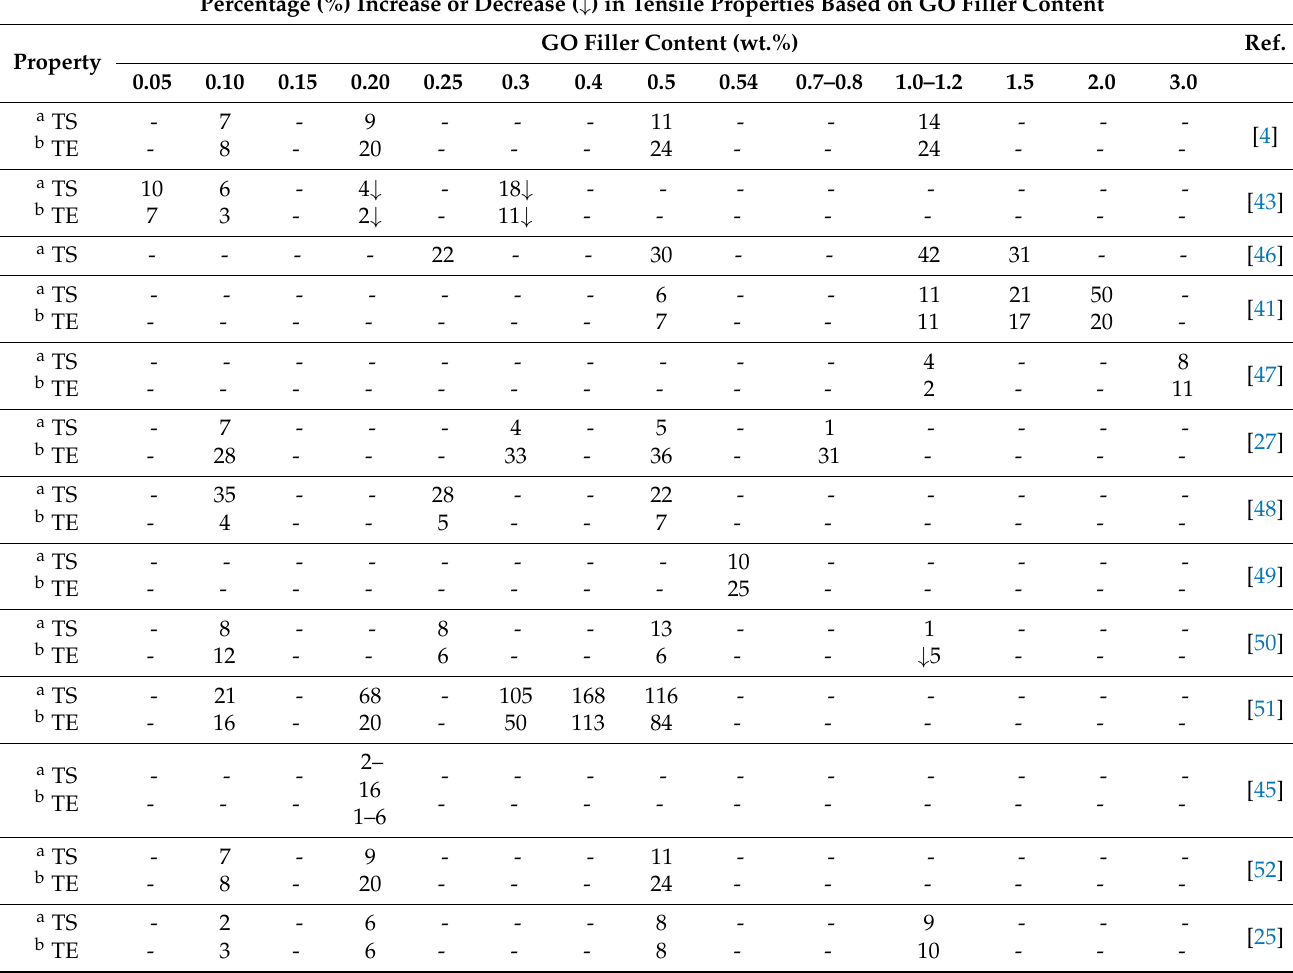
Table 2. A review summary of tensile properties of past research with synthetic epoxy/GO composites. Percentage (%) Increase or Decrease ( ↓ ) in Tensile Properties Based on GO Filler Content GO Filler Content (wt.%) Property